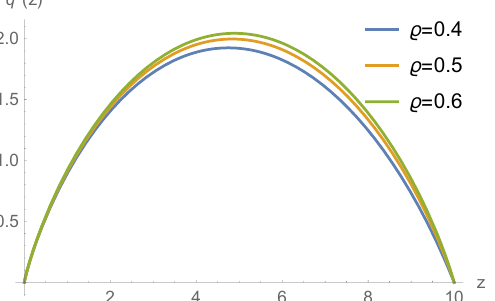
Figure 6. The optimal reinsurance policy with respect to z with di ff erent reinsurance safety loading (cid:37) = 0.4,0.5,0.6.